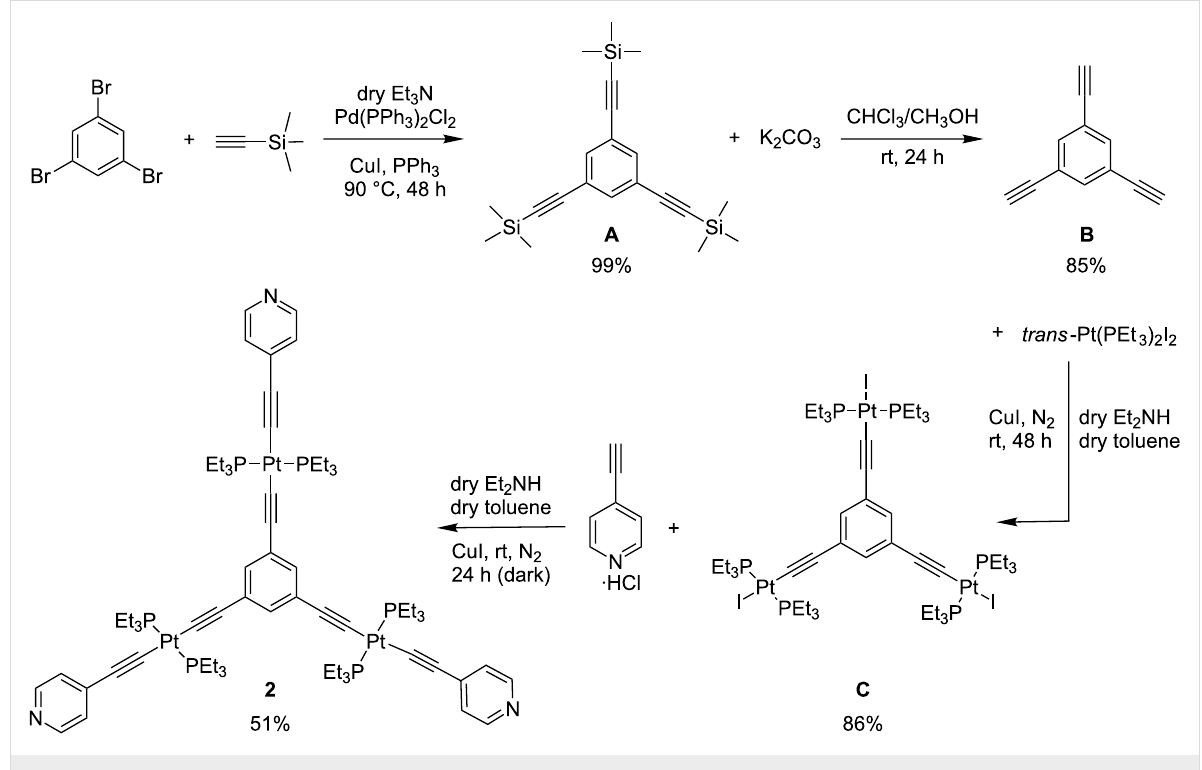
Scheme 2: Synthesis of the platinum metalloligand 2